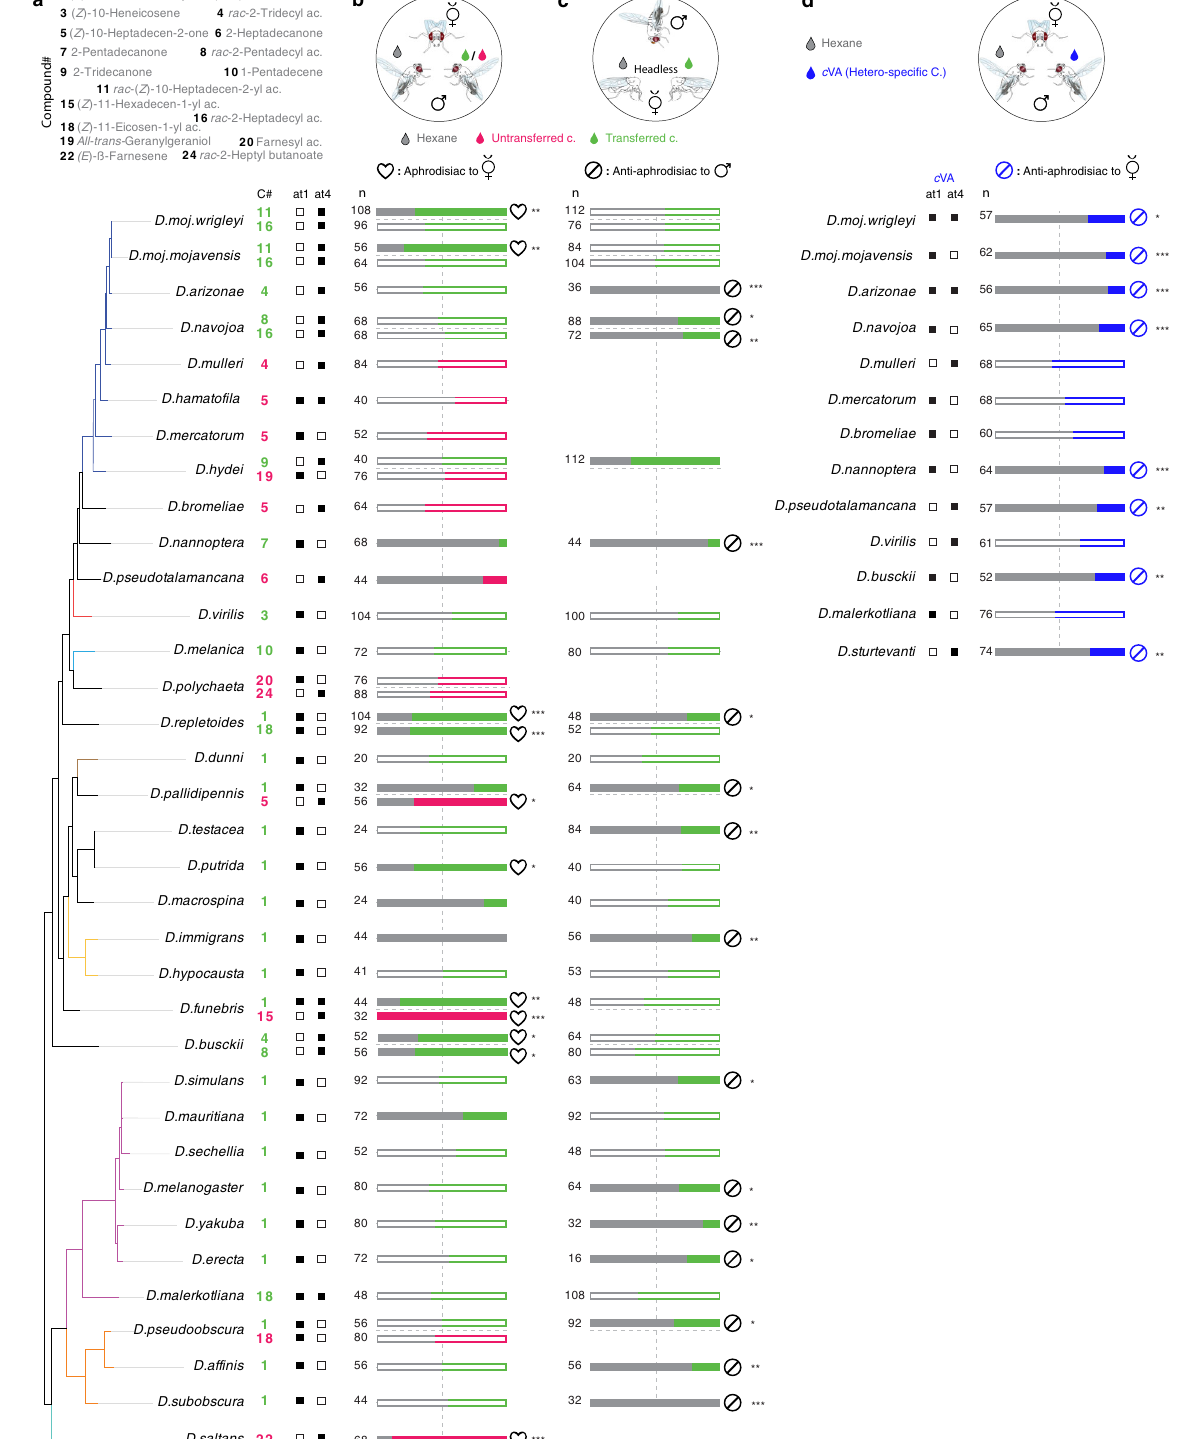
The high proportion — ~82% — of species that exhibit sexually dimorphic chemical pro fi les (Fig. 2b) indicates the signi fi cance of chemical communication in the genus Drosophila . This sexual dimorphism seems to positively correlate with fl ies ’ ability to mate under low light conditions 16,76 , while many of the chemi- cally monomorphic species cannot mate in the dark 16 . The latter often display sexually dimorphic color patterns, implying that